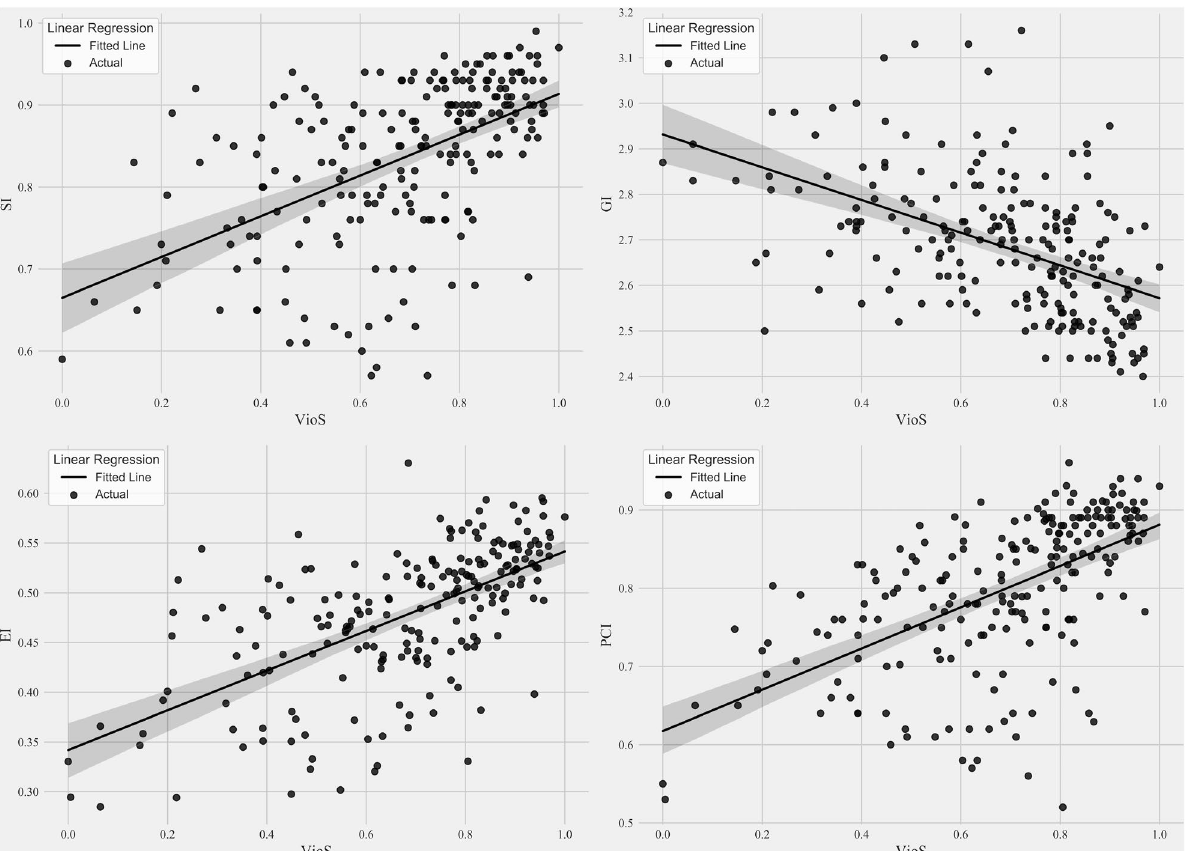
Figure 3. The univariate linear regression analysis results for the correlation of VioS with SI, GI, EI, and